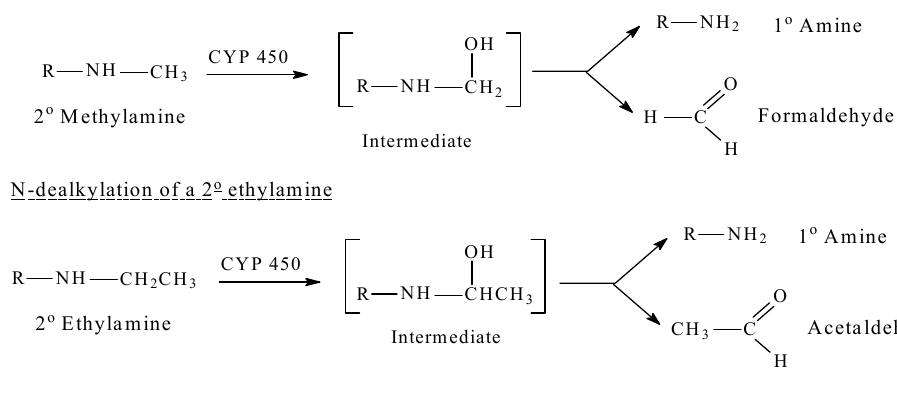
Figure 1. CYP 450 oxidative dealkylation of alkylamines. Depending on their class, alkylamino moieties interact with receptors or enzymes via hydrogen bonding, ion-dipole, ion-ion and van der Waals bindings as depicted in Figure 2 [2,3].